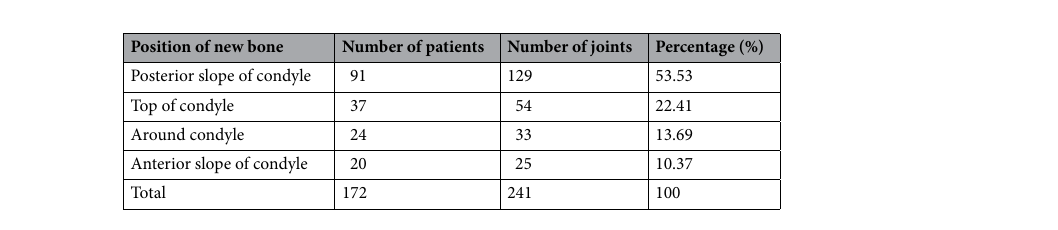
Table 4. Different position of the new bone formed on the